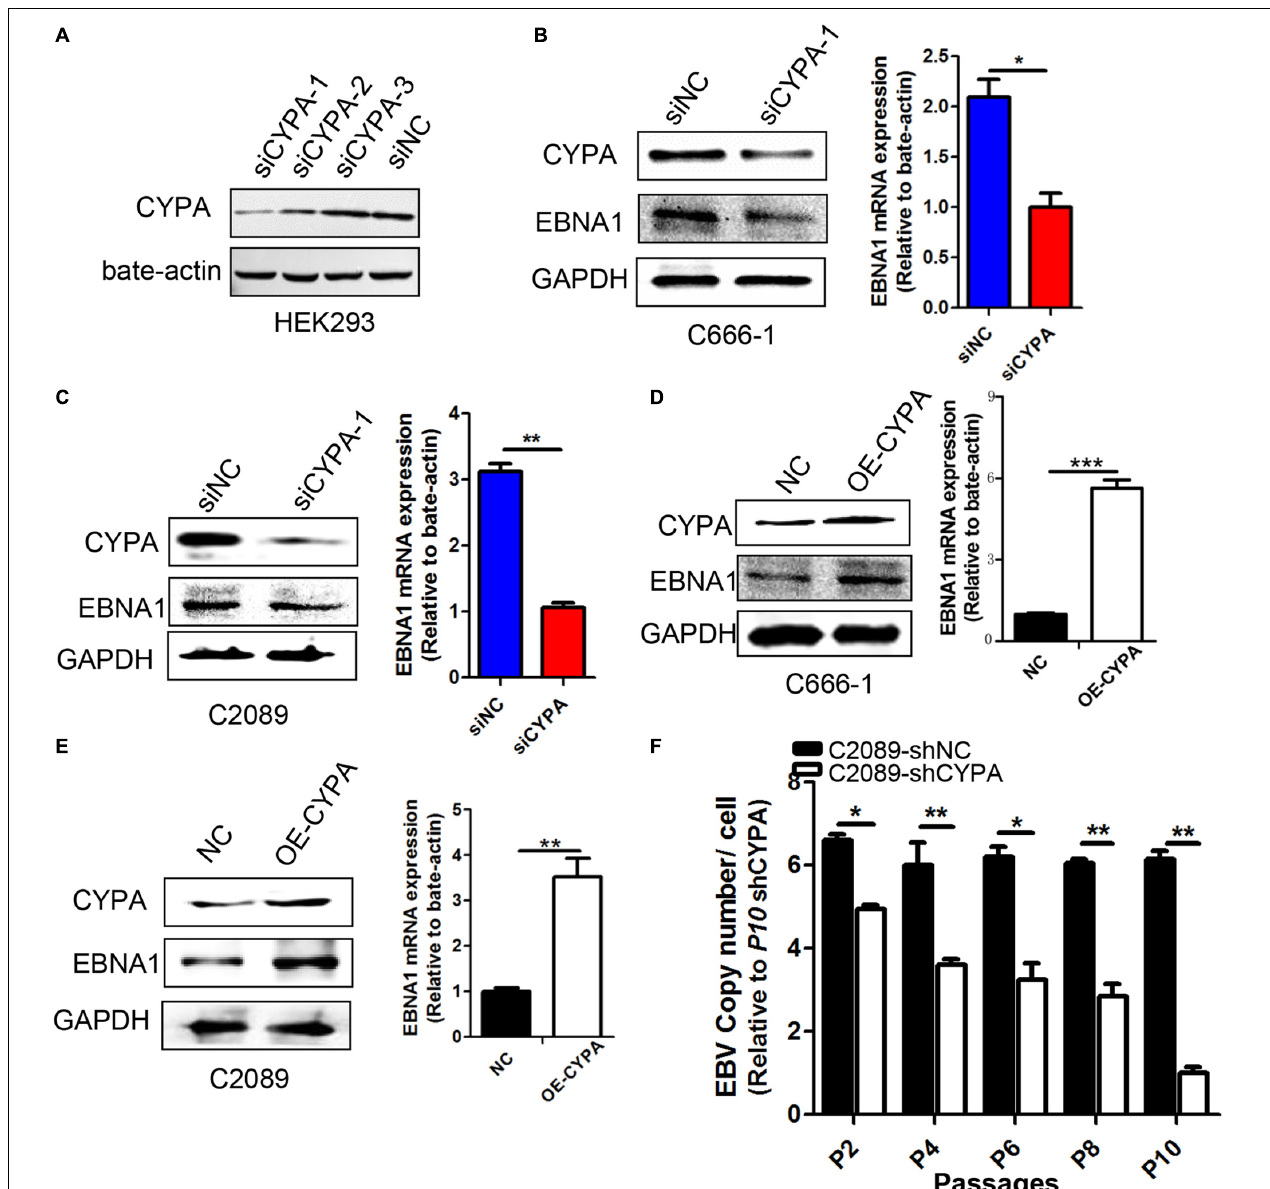
FIGURE 3 | Effect of CYPA on EBNA1 expression and loss of viral copy numbers. (A) Designations of the CYPA siRNAs. Three siRNAs for CYPA and a control siRNA were designed and used for detection of the interference efficiency. HEK293 cells were transfected with one of the siRNAs, and a WB assay was performed at 48 h post-transfection for analysis of the CYPA protein level. (B,C) Effect of siCYPA on EBNA1 expression in EBV-positive cells. Two EBV-positive cell lines [C666-1 (B) and C2089 (C) ] were used for siRNA transfection. At 48 h post-transfection, the cell lysates and RNA were subjected to the WB and RT-qPCR assays respectively, with siCYPA standarized to 1. (D,E) Effect of CYPA overexpression on EBNA1 expression at protein and mRNA levels in EBV-positive cells [C666-1 (D) and C2089 (E) ]. (F) The effect of CYPA depletion on loss of EBV copy numbers during passages. EBV-positive C2089 was used for shRNA stable transfection and selection. Cell lines stably transfected with shRNA-CYPA or shRNA-NC were established for the experiment. Cell dispersal for each passage was performed at a ratio 1:2. The copy number of the C2089-shCYPA cells was decreased compared with the C2089-shNC, with passage 10th of C2089-shCYPA set to 1. ∗ P < 0.05, ∗∗ P < 0.01, ∗∗∗ P <